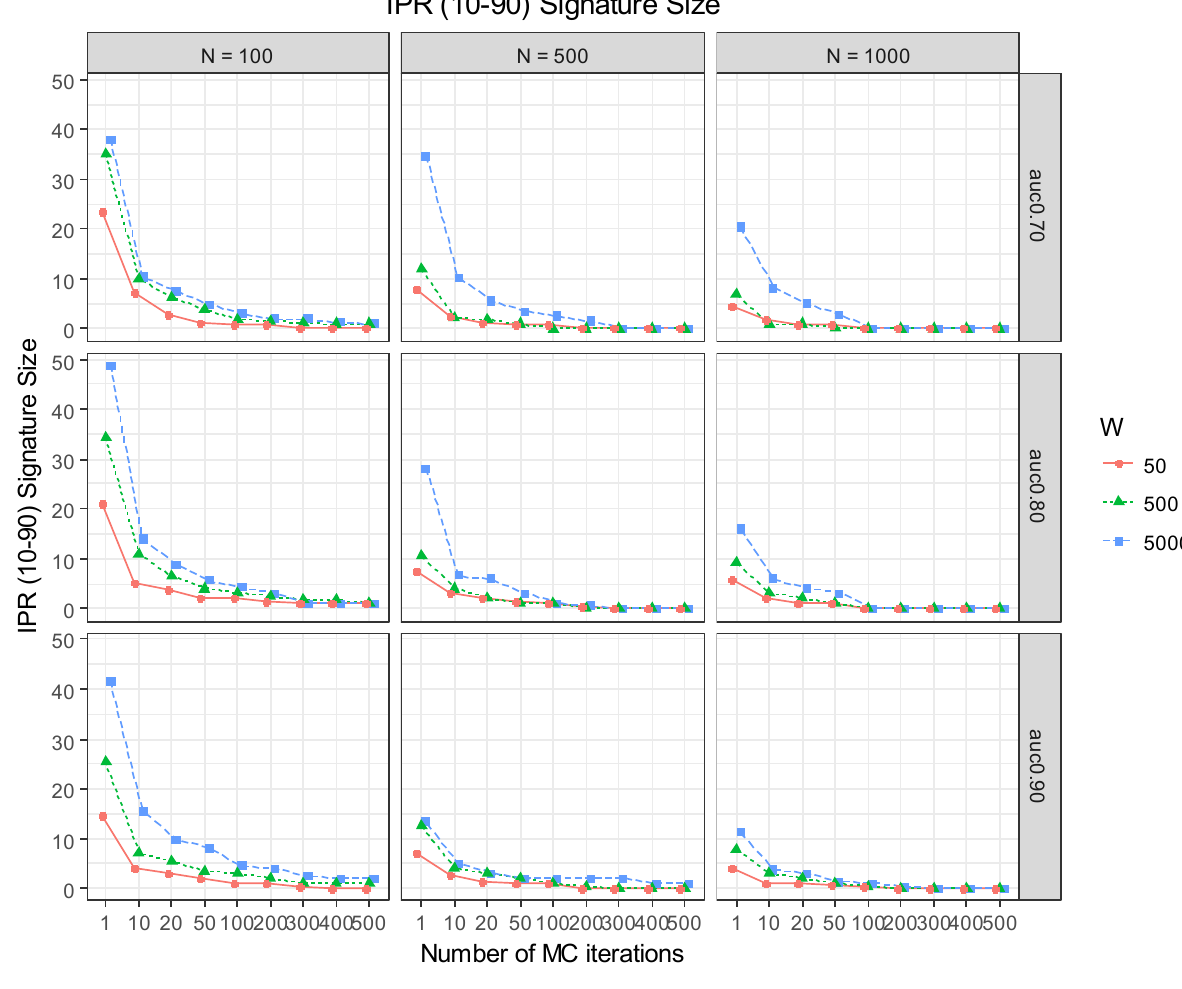
Figure 4. Inter-percentile (10~90%) range (IPR) values of the signature size corresponding to the λ opt estimates from 100 replicate runs of glmnet (s = 1) and MCglmnet with different numbers of MC iterations (s = 10, 20, 50, 100, 200, 300, 400, 500) and different levels of signal strength (AUC = 0.7, 0.8, 0.0) are summarized in this graph.